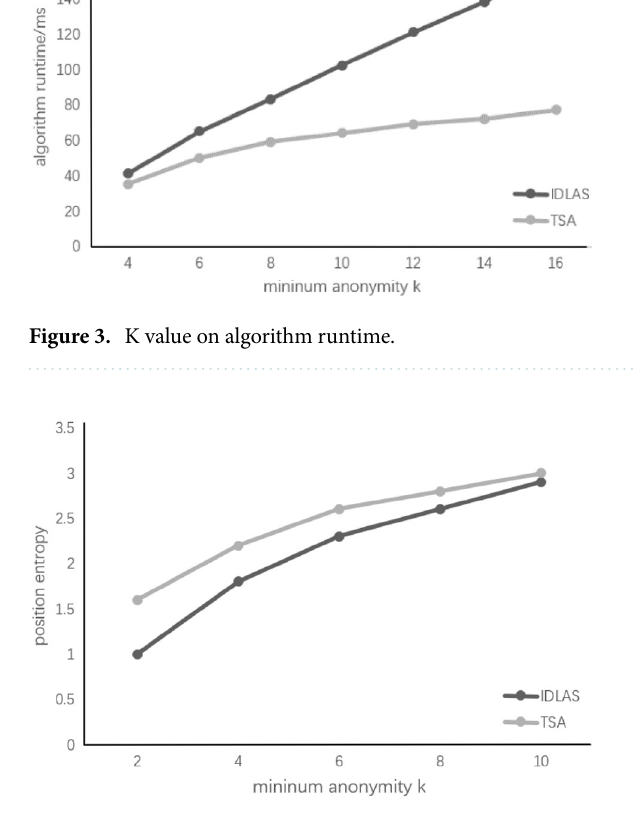
Figure 4. Location